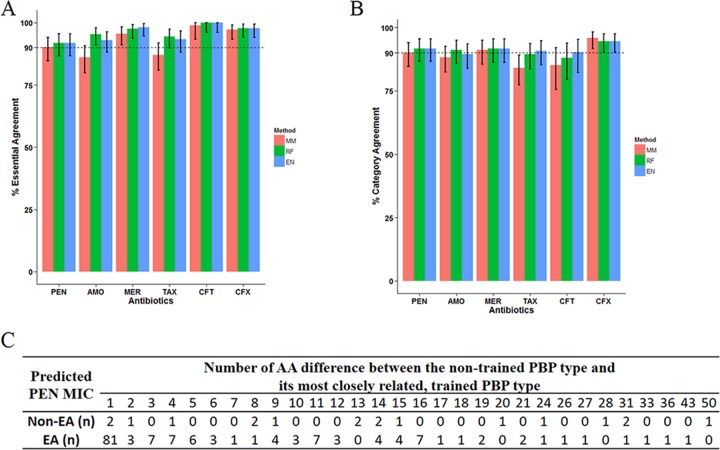
Agreement between the predicted MIC and the microdilution MIC among isolates of nontrained PBP types. The mode MIC (MM) model approximated a nontrained PBP type by the most closely related trained PBP type and assigned the most frequently seen MIC of the trained PBP type to the test isolate. For the random forest (RF) and elastic net (EN) models, any amino acid not seen in the training data set was approximated by a corresponding training amino acid with the least BLOSUM62 distance. See Materials ad Methods for detailed model description. (A and B) The rates of essential agreement (A) and category agreement (B) were calculated for the six antibiotics. Error bars are 95% CIs. (C) Relationship between the number of amino acid (AA) differences and outcome of EA for PEN MIC (in micrograms per milliliter) predicted by the MM method.